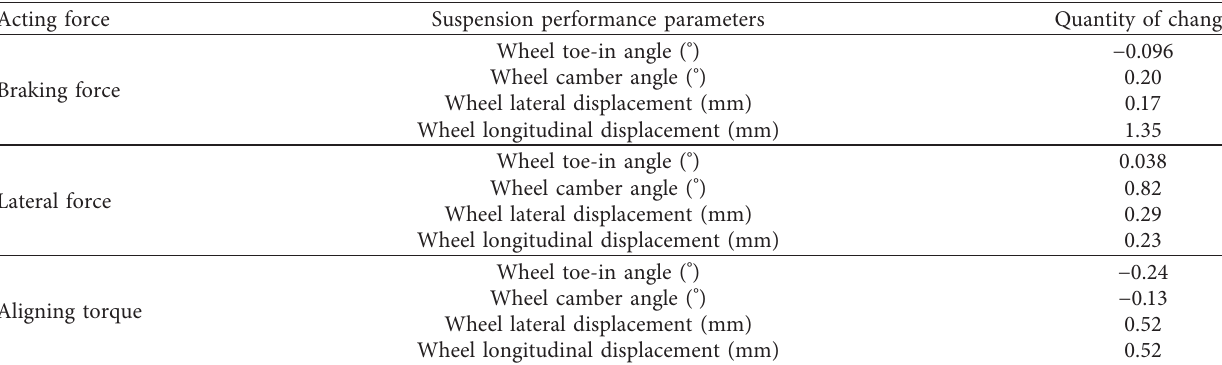
Table 8: Amount of variation in suspension performance